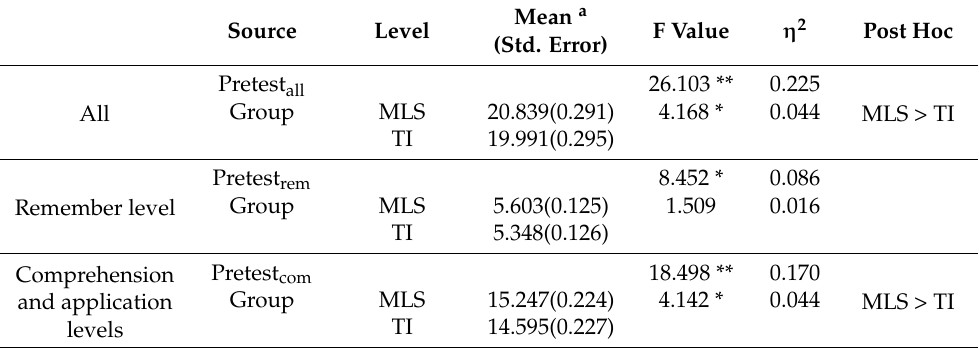
Table 6. ANCOVA summary table of the pretest and posttest scores of mathematics learning achieve- ment